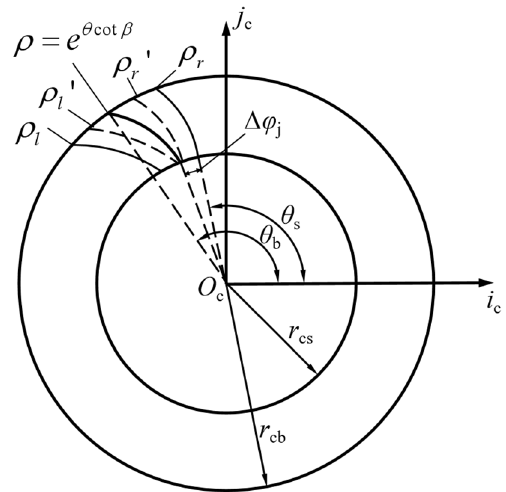
Figure 3. Tooth alignment curve of crown gear.